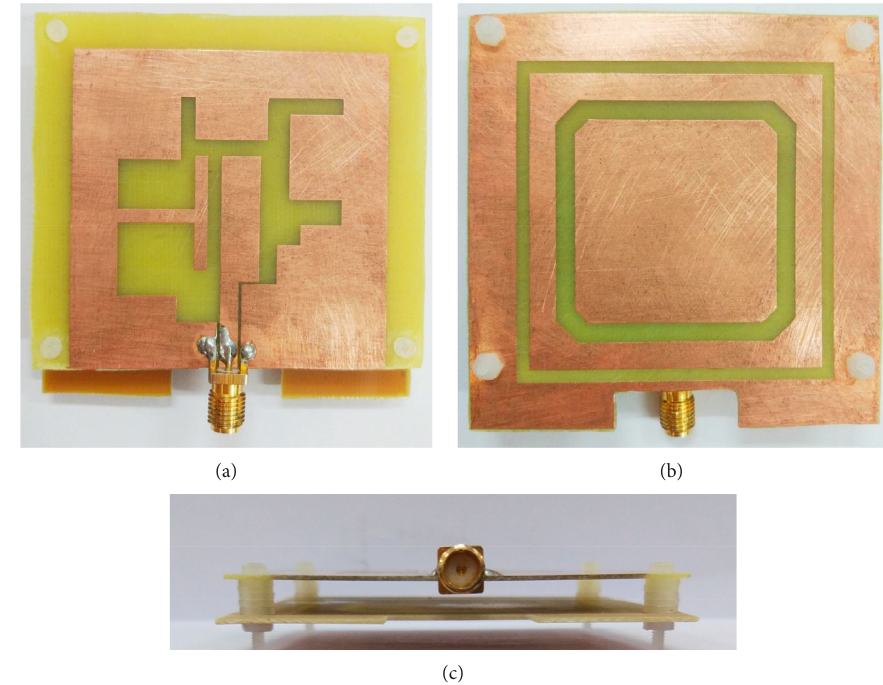
Figure 10: The fabricated prototype of the proposed antenna. (a) Top view, (b) bottom view, and (c) side